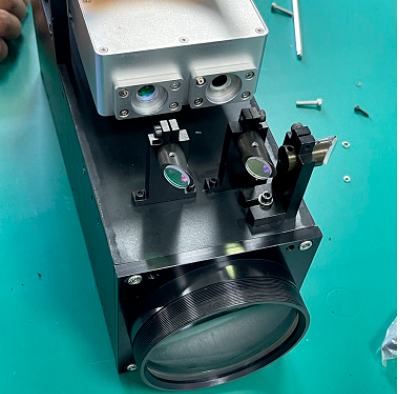
Figure 3. A handhold Raman Spectroscopy detection device.